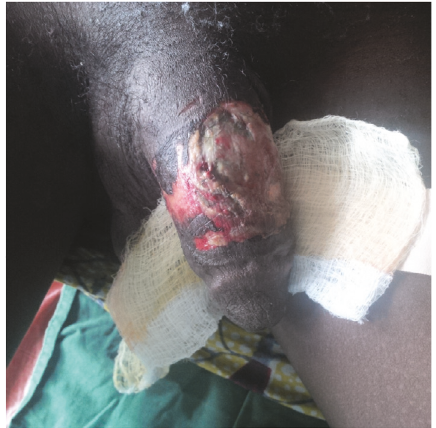
Figure 5: Penile ulcer granulating well 2 weeks after removing the constricting